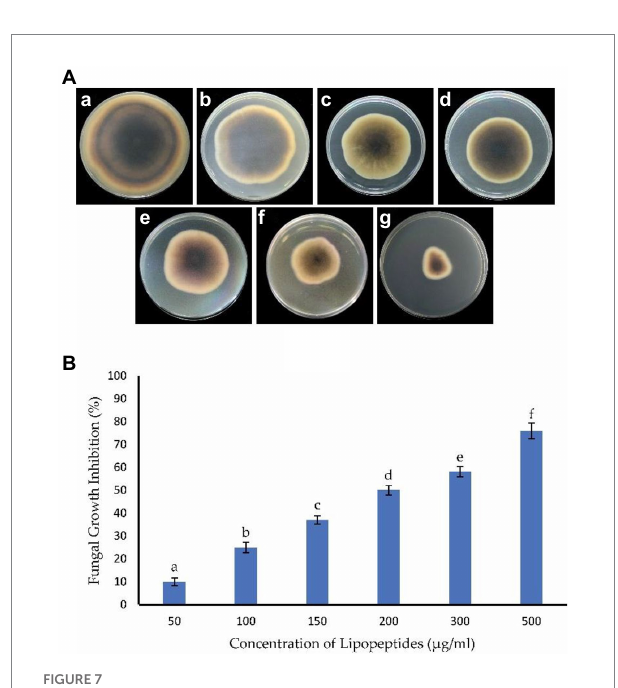
FIGURE 7 Antagonistic effect of B. subtilis Y17B LPs against A. alternata . (A) Assessment of LPs at different concentrations against A. alternata . The reverse side of the plate is shown. (A) Control, (B) 50 μ g/mL of LPs, (C) 100 μ g/mL of LPs, (D) 150 μ g/mL of LPs, (E) 200 μ g/mL of LPs, (F) 300 μ g/mL of LPs, and (G) 500 μ g/mL of LPs. (B) Graph representing the antagonistic effect of LPs on A. alternata mycelium inhibition (%). The same letters are not significantly different from each other. Analyzed using a LSD test ( p ≤ 0.05).